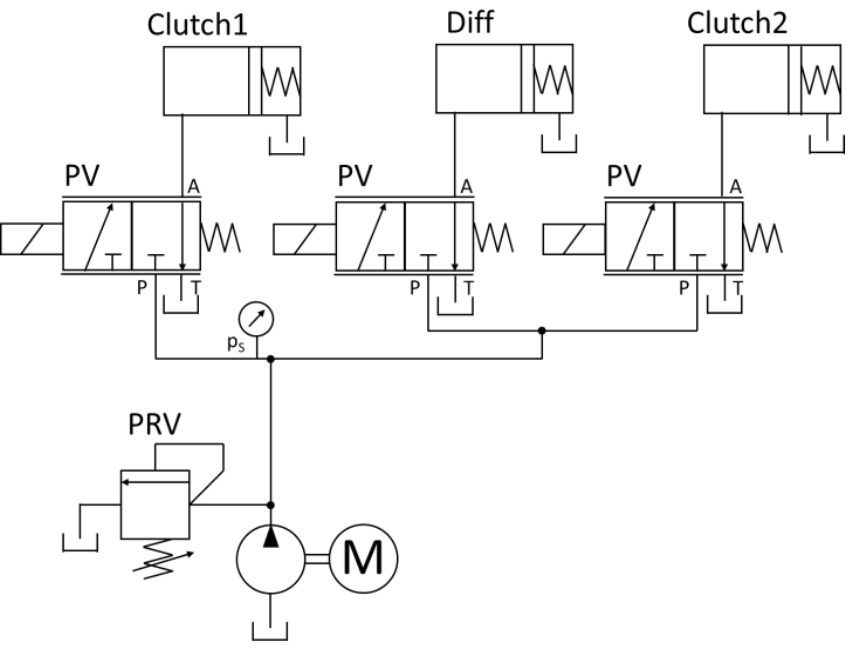
Figure 1. Hydraulic scheme of the Dual-Clutch Transmission (DCT) power transmission system.